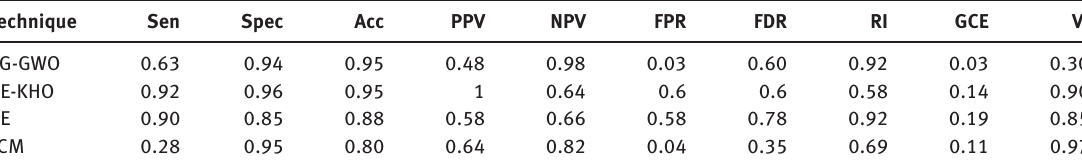
Table 2: Comparison of Segmentation Results.